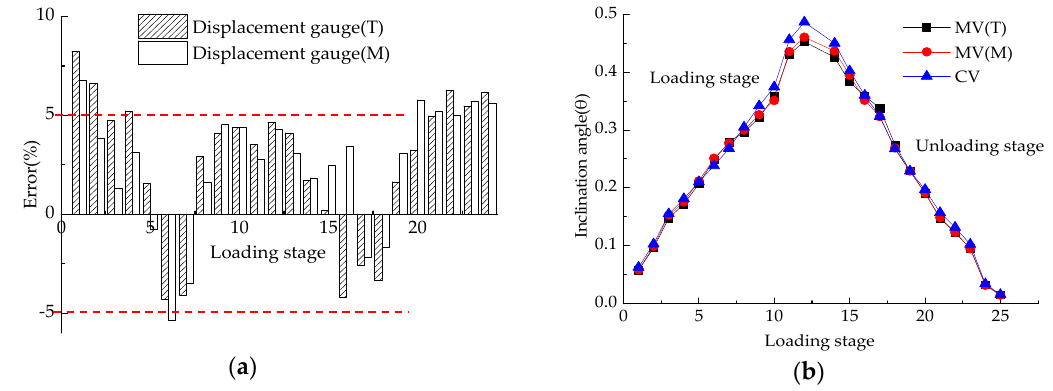
Figure 13. Comparison of error and inclination angle: ( a ) Errors between experiment values from the top LVDTs or middle LVDTs and calculated value from FBGs; ( b ) Inclination angles.